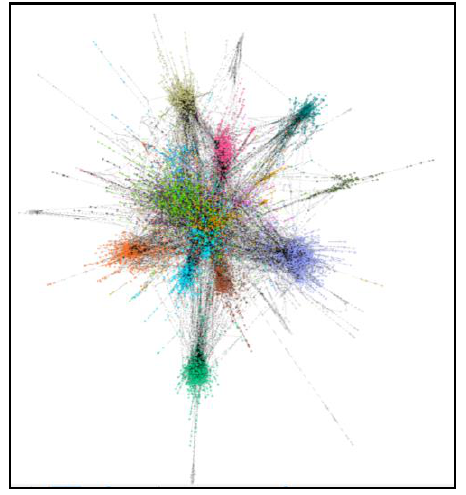
Figure 2. Show on social network with ForceAtlas2 layout